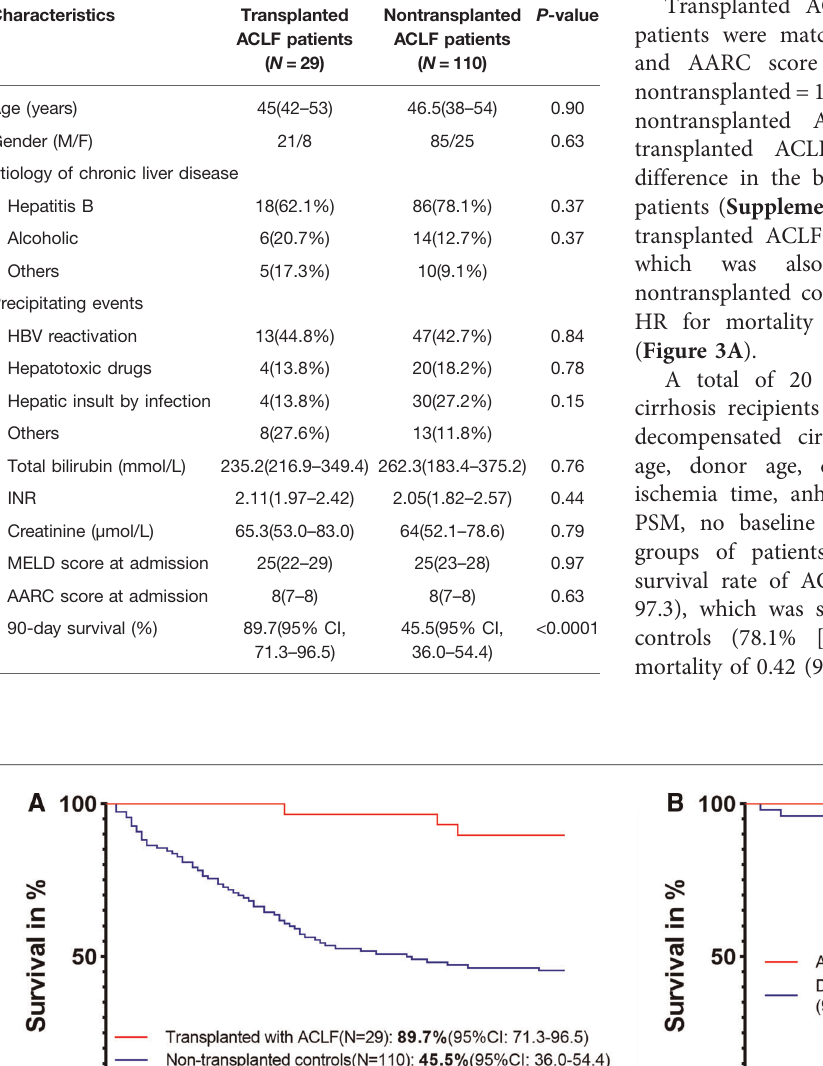
TABLE 1 | Main characteristics of transplanted and nontransplanted ACLF patients.